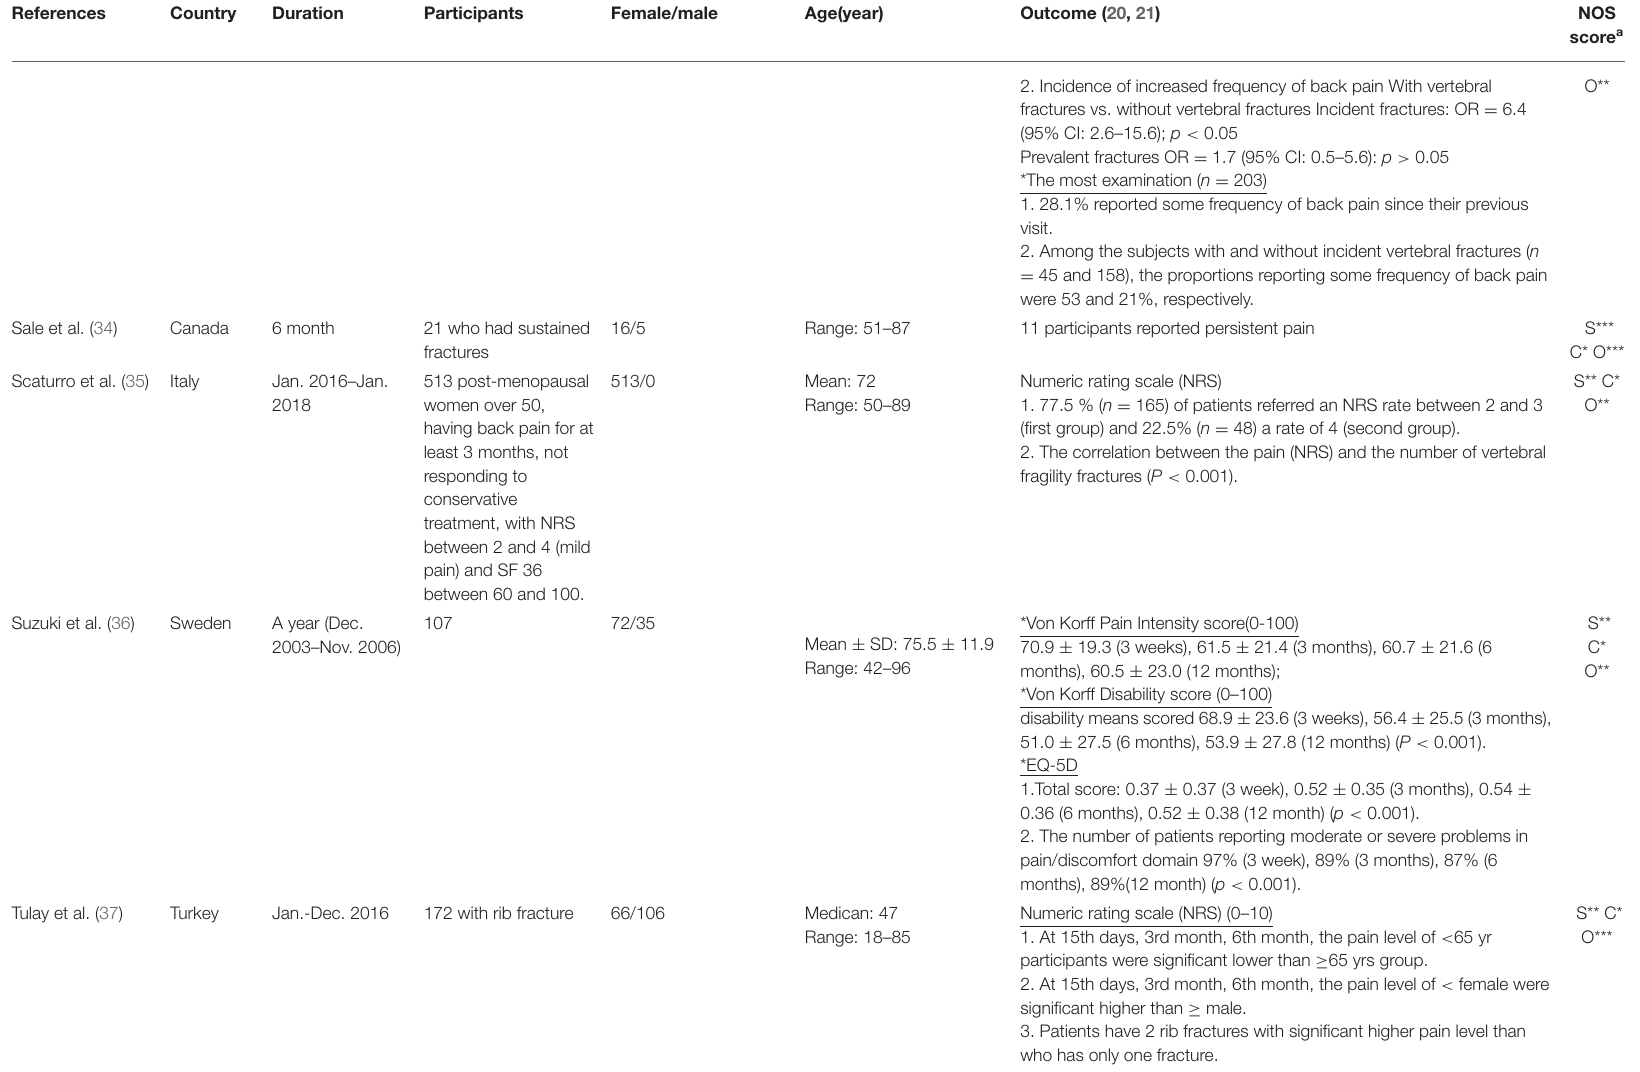
Medican: 47 Numeric rating scale (NRS) (0–10) Range: 18–85 1. At 15th days, 3rd month, 6th month, the pain level of < 65 yr participants were significant lower than ≥ 65 yrs group. 2. At 15th days, 3rd month, 6th month, the pain level of < female were significant higher than ≥ male. 3. Patients have 2 rib fractures with significant higher pain level than who has only one